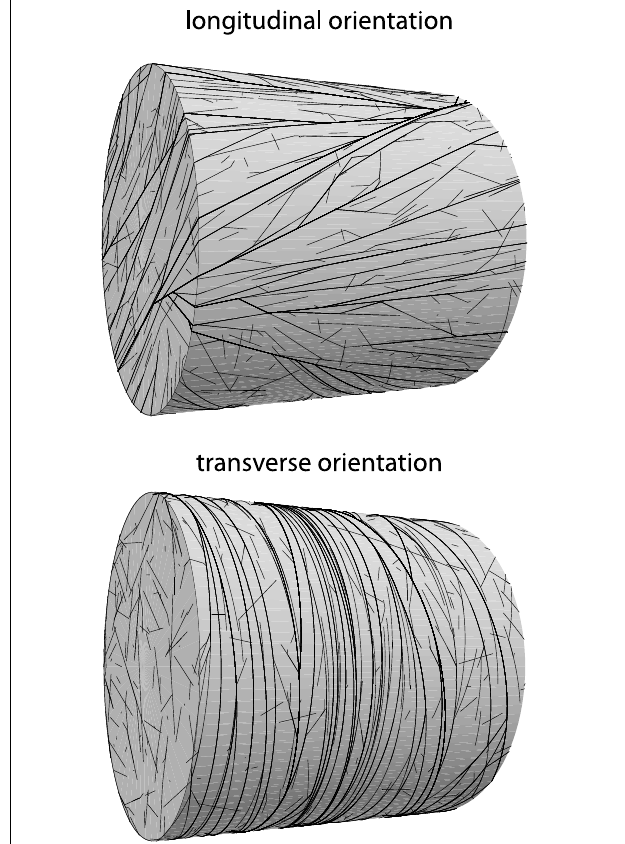
FIGURE 12 | Examples of oriented alignment on cylindrical domains. Top: longitudinal orientation ( R 2 = 0 . 63 ; (cid:6) 2 = 70 ◦ ), default parameters at t = 20h. Bottom: transverse orientation ( R 2 = 0 . 88 ; (cid:6) 2 = 7 ◦ ). Simulation parameters as on top, except spontaneous catastrophe rate on cylinder caps that have been increased by a factor 2, resulting in reliable transverse ordering.